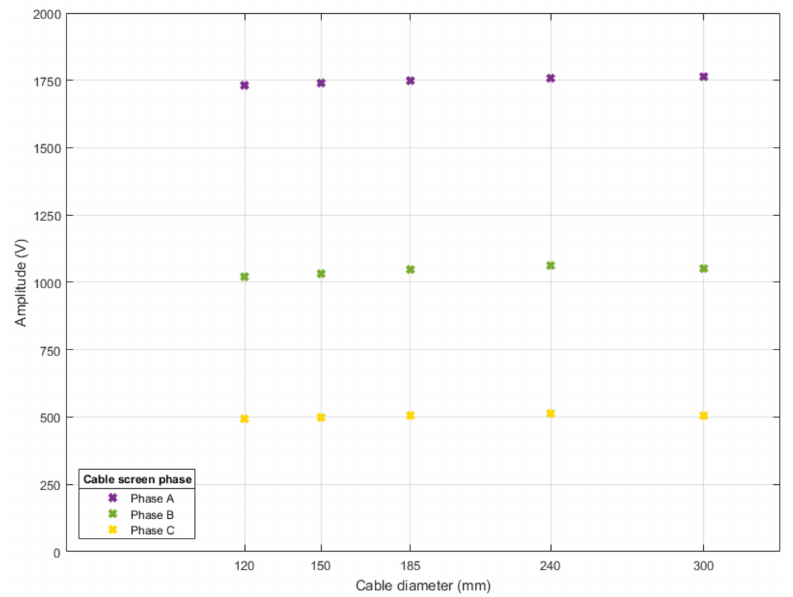
Figure 7. Maximum overvoltage in Terminal J for different conductor cross-sections during a ground fault in phase A.